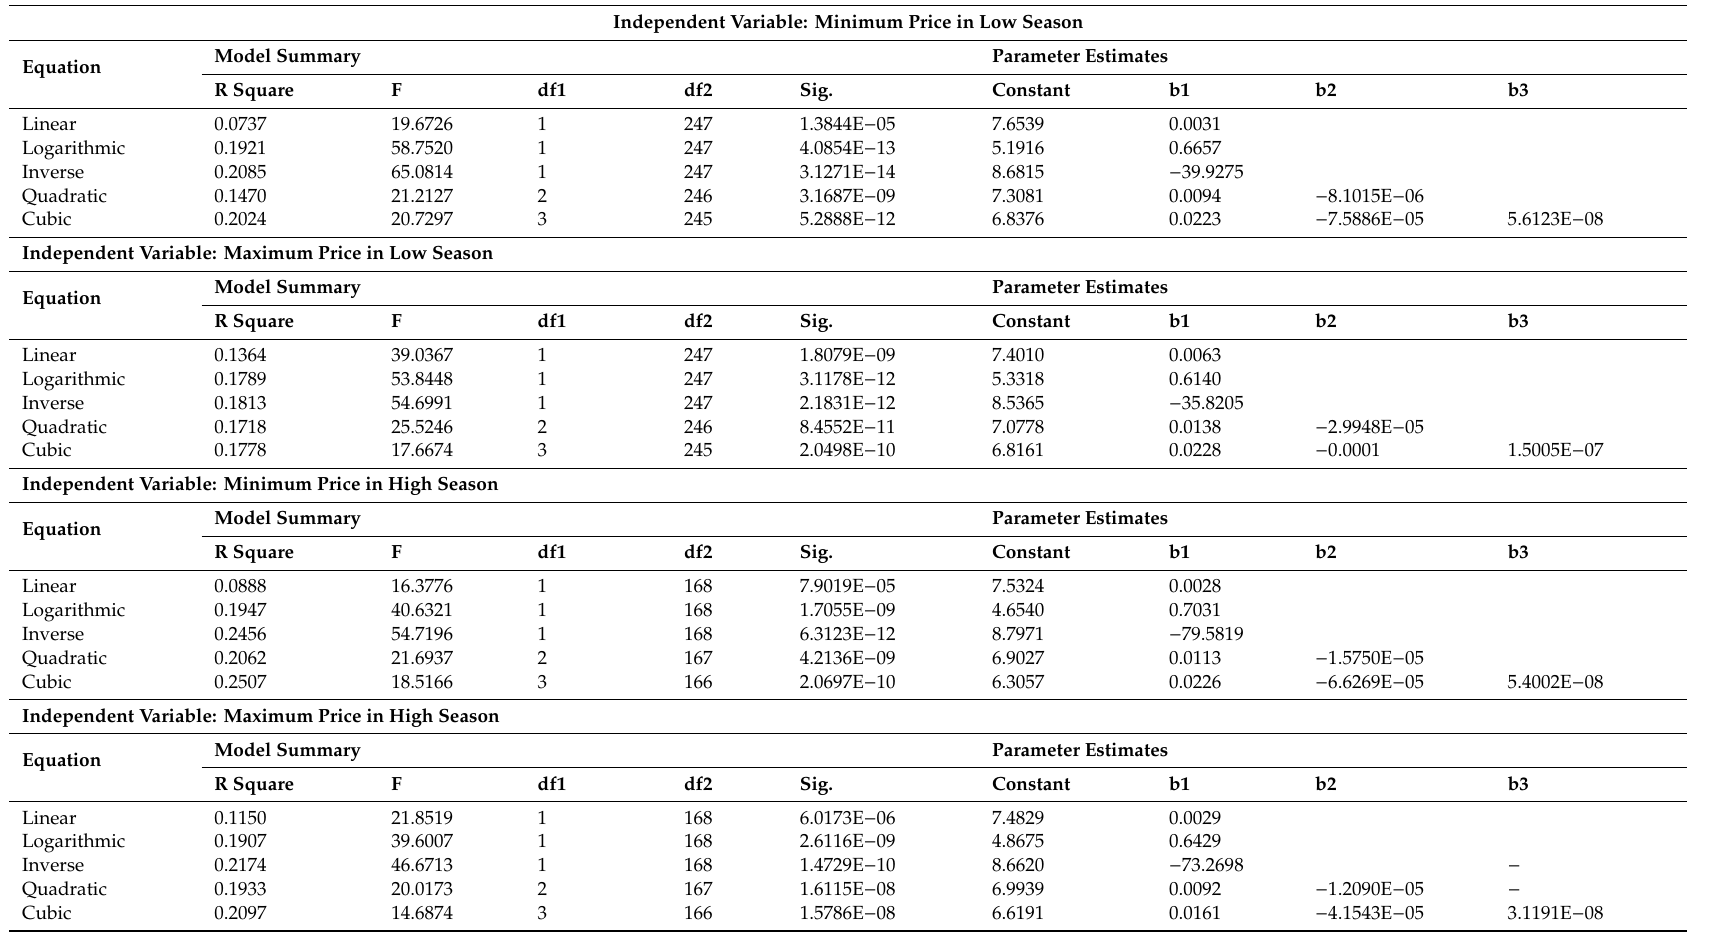
Table 6. Model summary and parameter estimates of regression analysis in Gran Canaria destination with Q as dependent